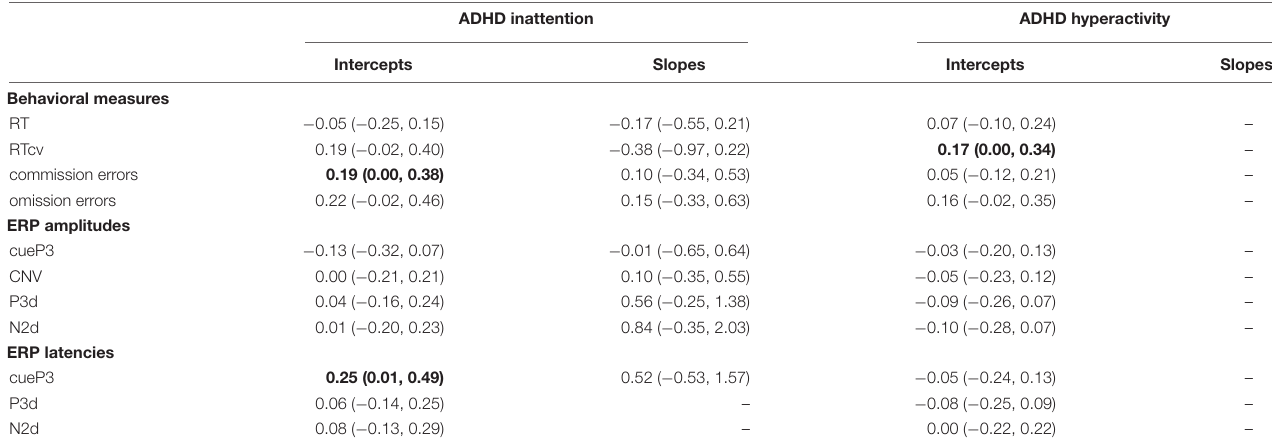
TABLE 4 | Correlation coefficients with 95% confidence intervals between self-reported symptoms (ADHDH inattention and ADHD hyperactivity) and the visual continuous performance test (VCPT) variables, behavioral measures and event-related potential (ERP) amplitudes and